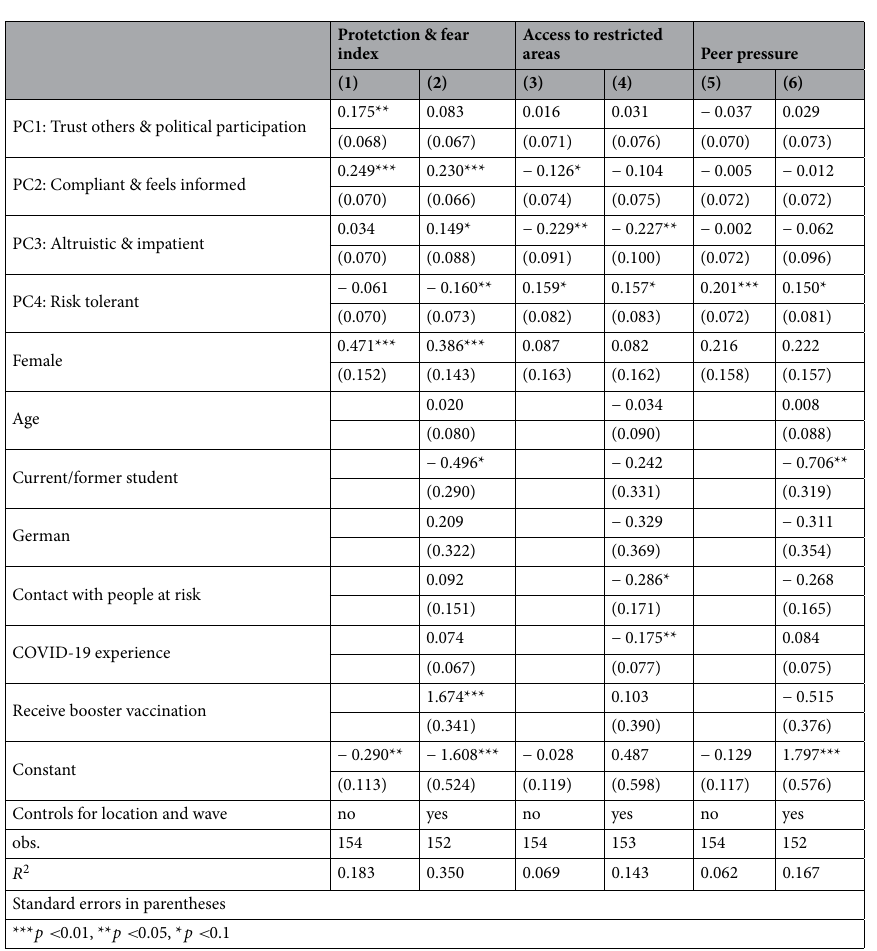
Table 2. OLS regressions on subjects’ motivations to become